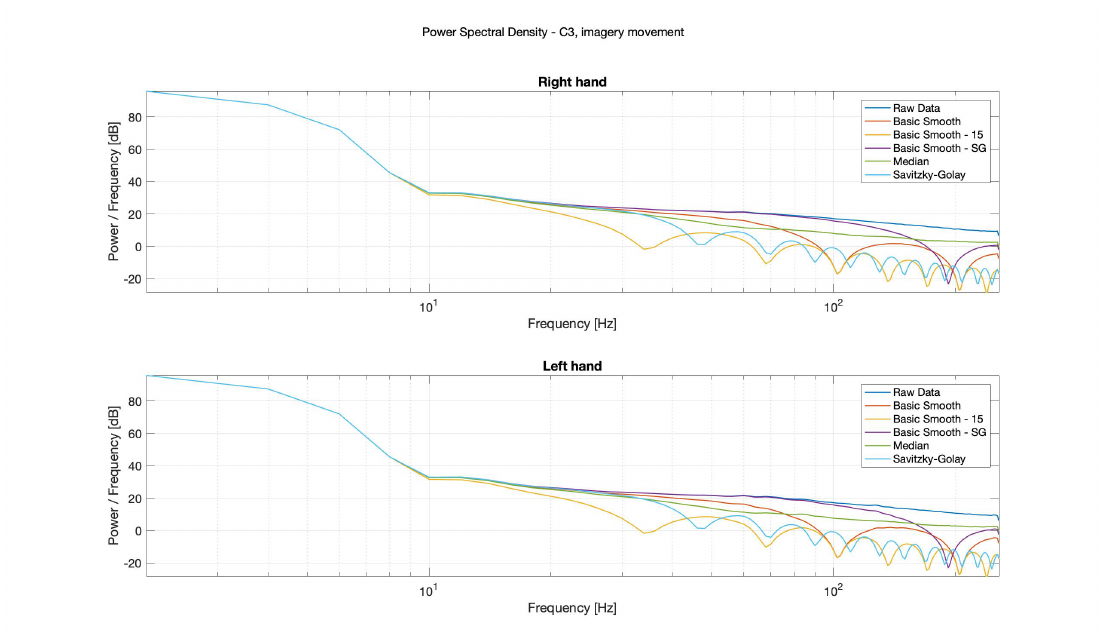
Figure 16. PSD—Bode plots, C3, imagery movement, right ( top ) and left ( bottom )